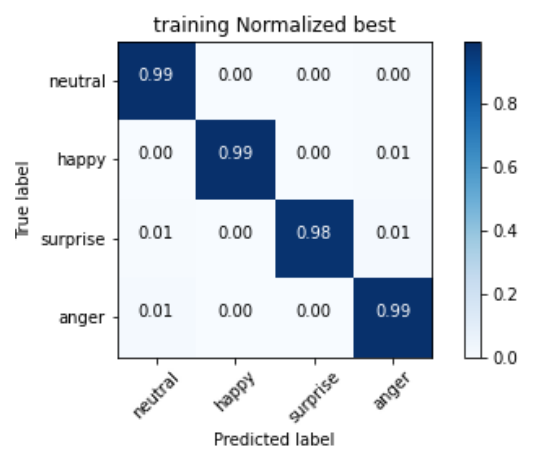
Figure 7. Confusion matrix of the training set for the network InceptionResNetV2. The confusion matrix of the validation set relative to each tested network is shown in Figure 8.